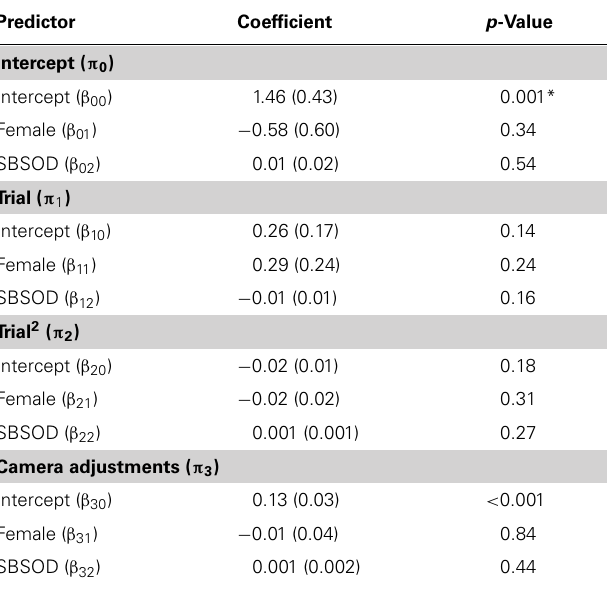
Table 4 | Regression coefficients for distance to the route end on south trials.